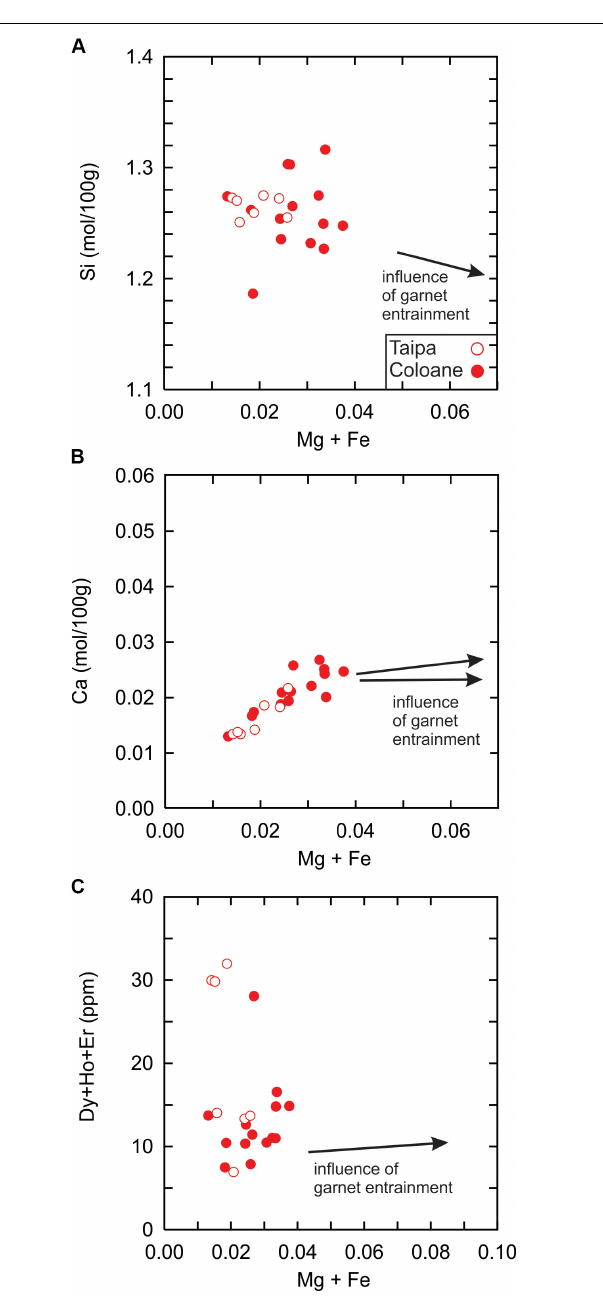
FIGURE 11 | (A) Si (molar) vs. maficity (Mg + Fe molar) of the Taipa and Coloane leucogranites. (B) Ca (molar) vs. K (molar) of the Taipa and Coloane granites. (C) Dy + Ho + Er vs. maficity (Mg + Fe molar) of the Taipa and Coloane leucogranites. The direction of garnet entrainment from Stevens et al. (2007). melting. The flat chondrite normalized heavy rare earth element patterns (Gd N /Yb N = 0.6 − 1.5) of the rocks is also consistent with the absence of residual garnet in the source ( Figure 5B